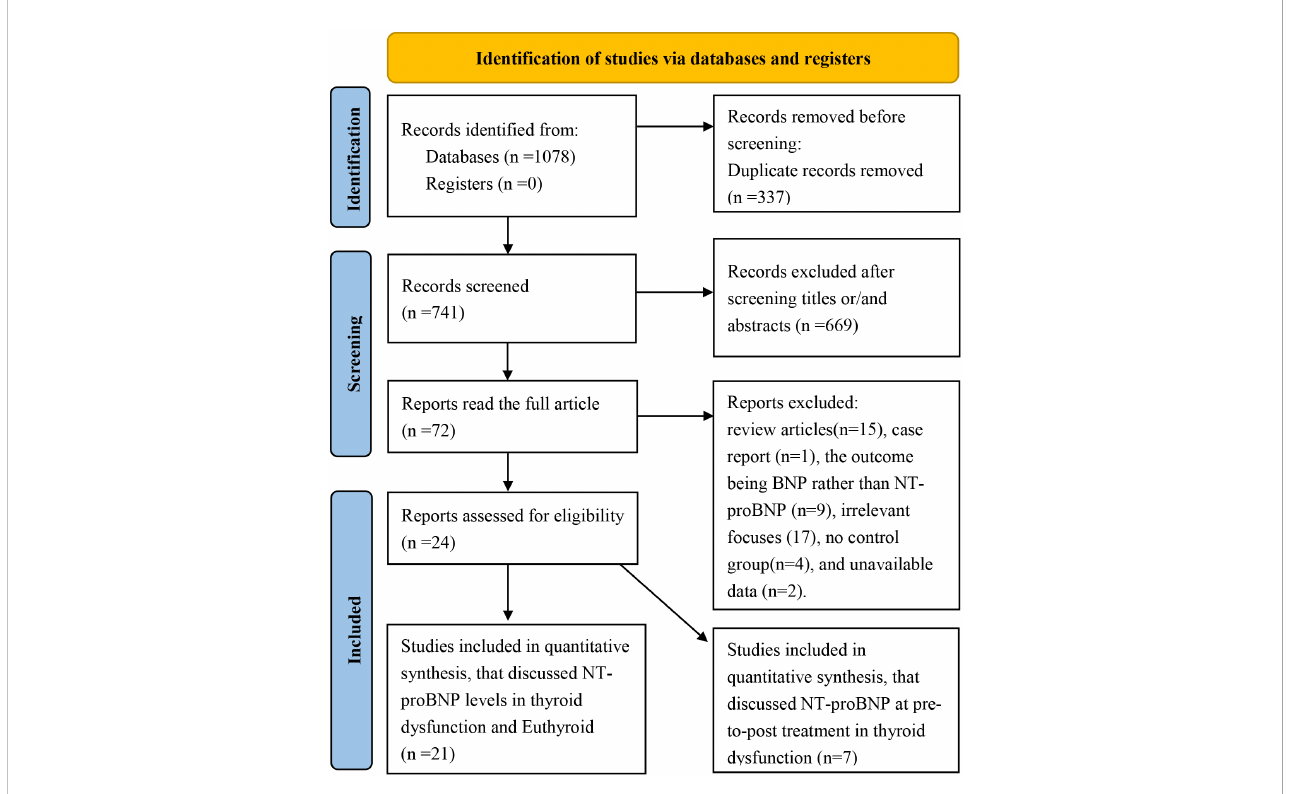
FIGURE 1 PRISMA fl ow diagram of this systematic review and